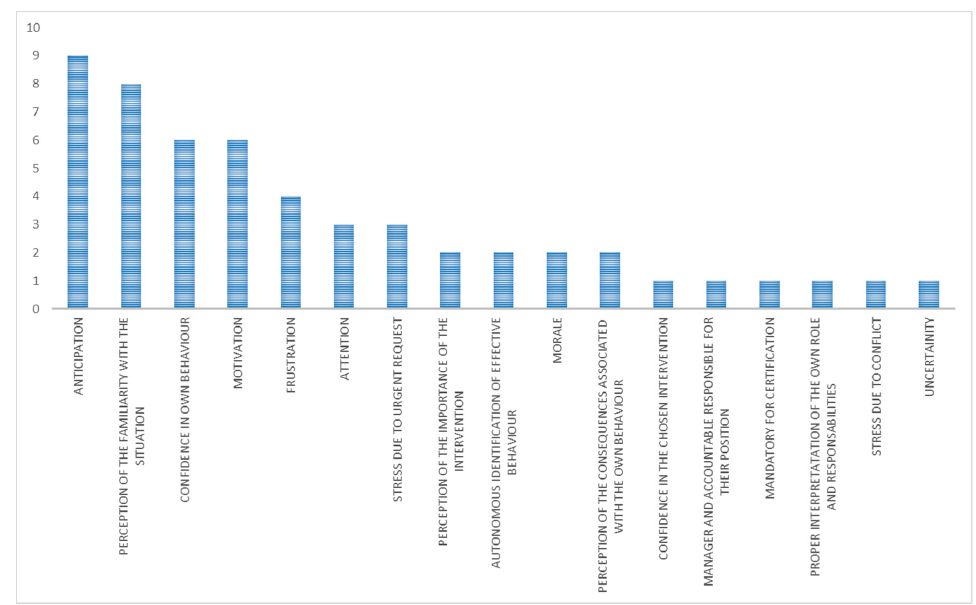
Figure 3. Main mechanisms (in terms of number of occurrences) in organizational interventions with unexpected outcome.